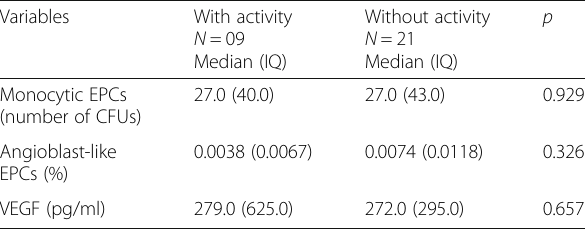
Table 4 EPCs and VEGF in Takayasu ’ s arteritis patients users